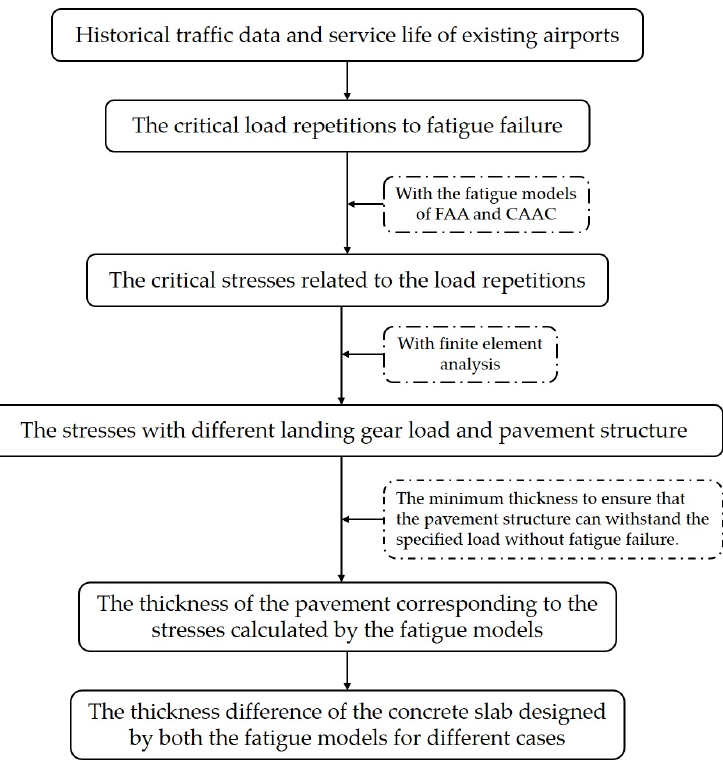
Figure 6. The flowchart of comparison analysis.